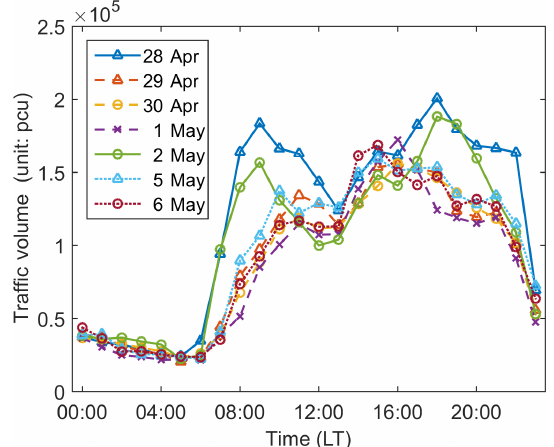
Figure 13. The diurnal variation in the total traffic volume in the simulation street network (solid line: normal weekday; dashed line: national holiday; dotted line: normal